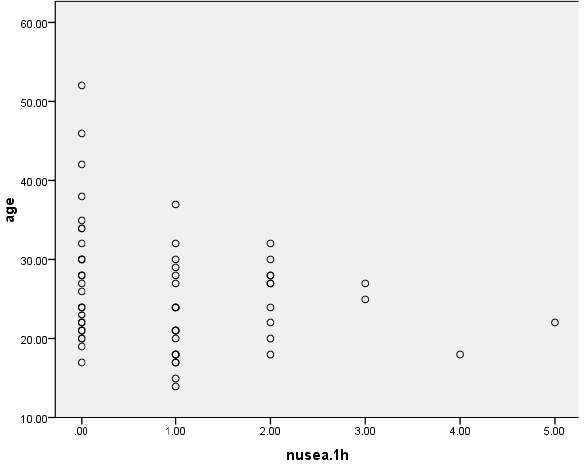
Figure 4. The relationship between age and nausea severity 60 minutes after charcoal consumption. * Pearson correlation test was